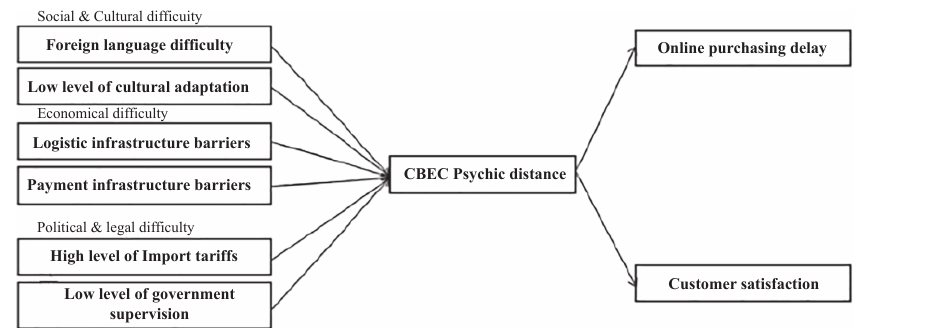
Table 2. Factors of psychic